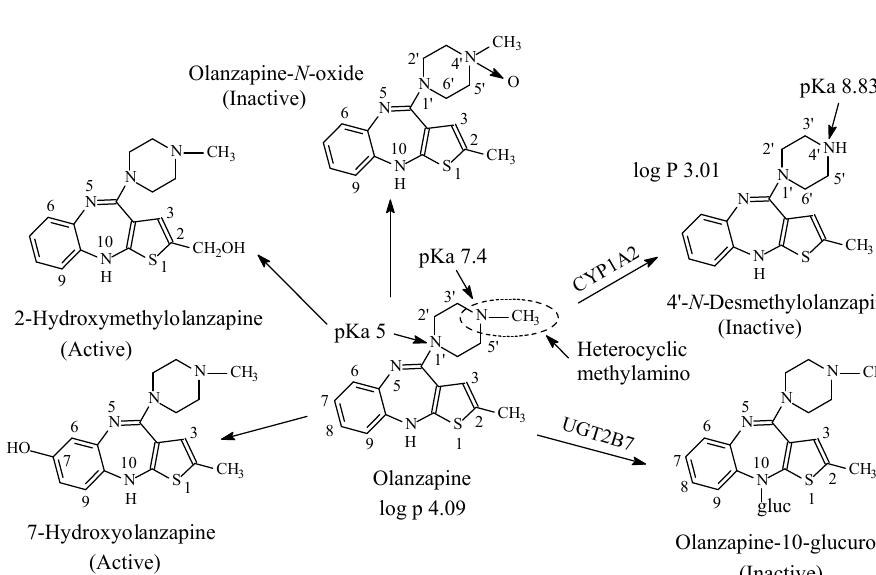
Figure 17. Metabolic pathways of mirtazapine.